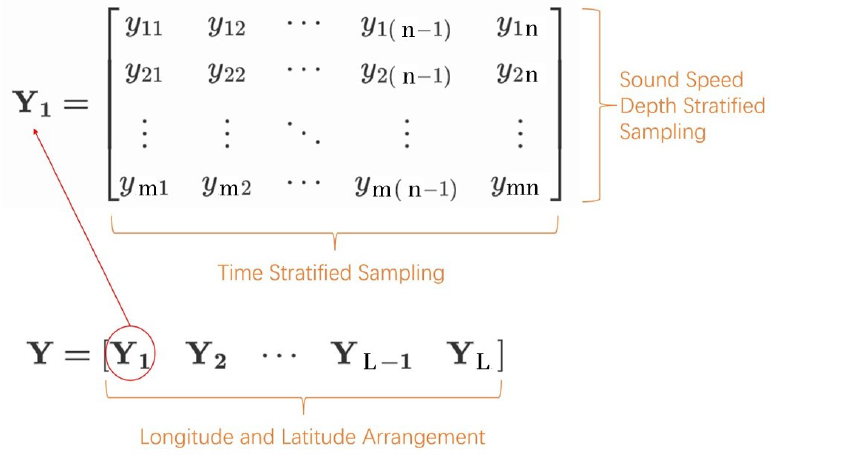
Figure 2. Data matrix